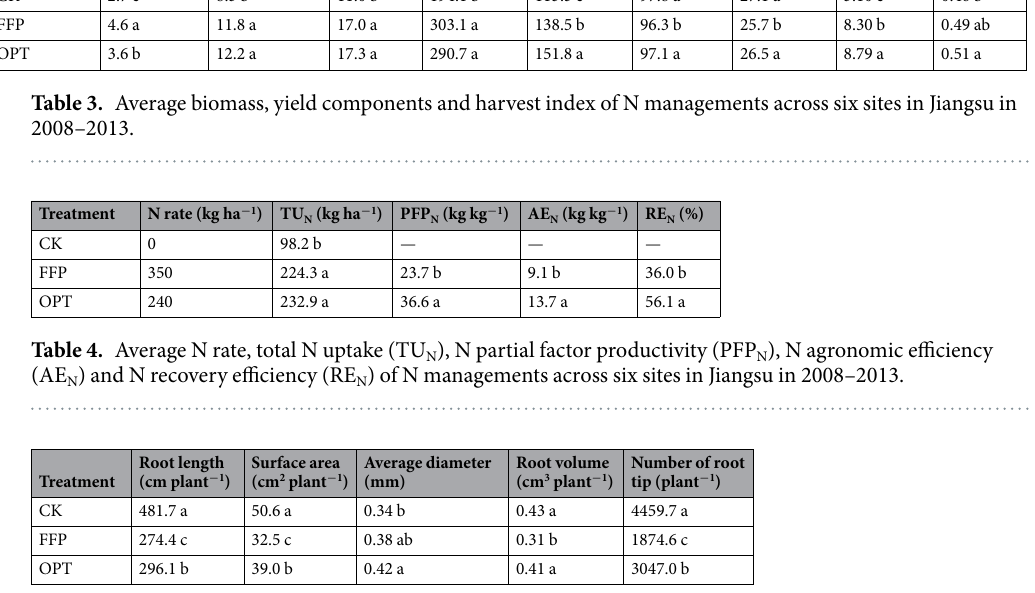
Table 5. Root length, superficial area, average diameter, root volume and number of root tip of N managements of rice roots at the seedling stage 10 days after transplanting in Rugao sites in